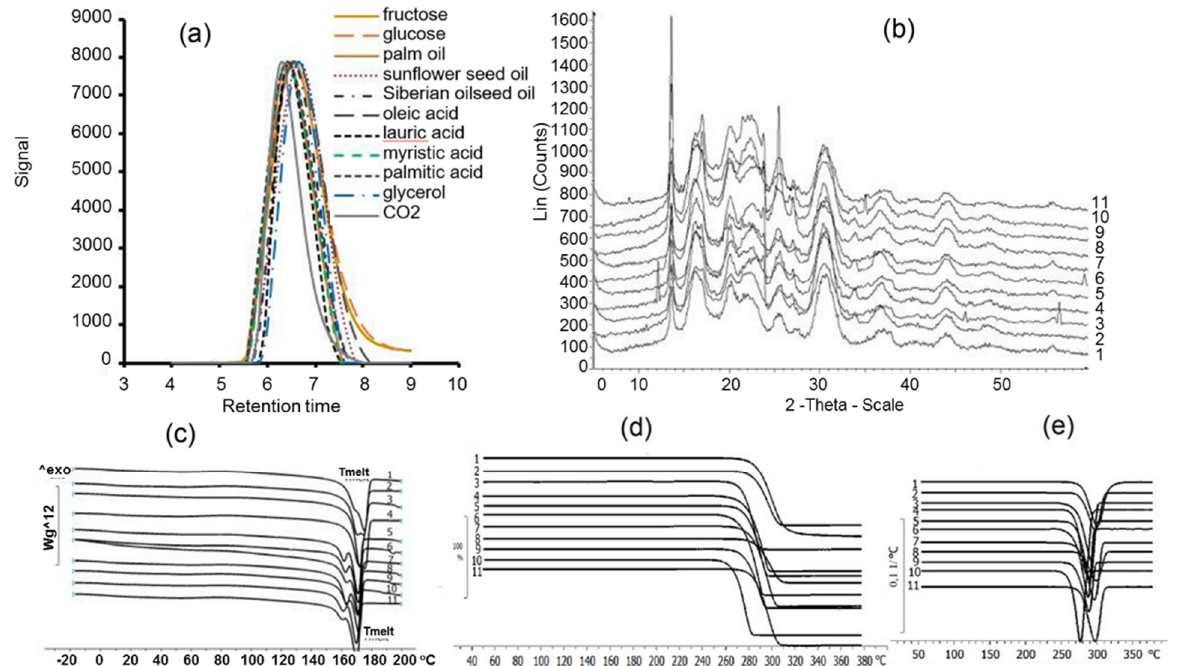
Figure 4. Physicochemical properties of PHAs synthesized by Cupriavidus necator IBP/SFU-1 from various carbon sources: ( a ) molecular weight distribution chromatogram, ( b ) the X-ray, ( c ) DSC, ( d ) TGA, ( e ) DTG (numbering of Samples 1–11 is the same as in Table 1).